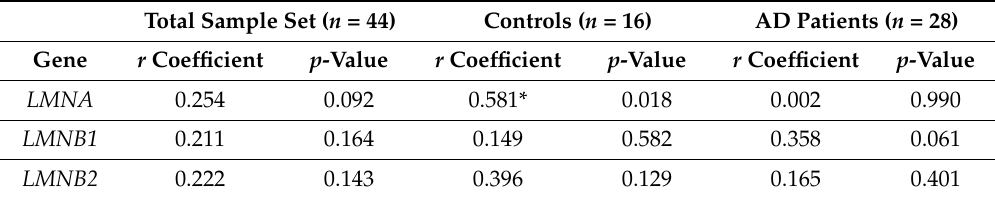
Table 1. Correlation between age and lamin gene